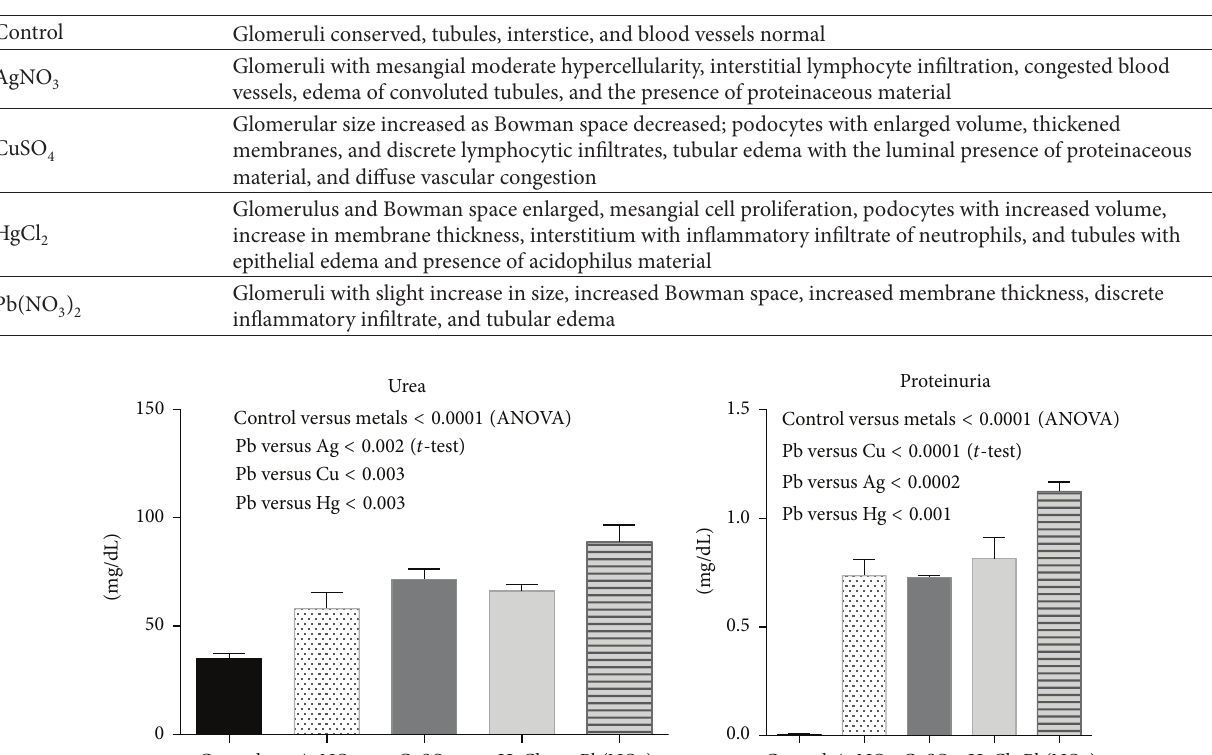
Table 1: Major histological findings in animals intoxicated with metal ions.